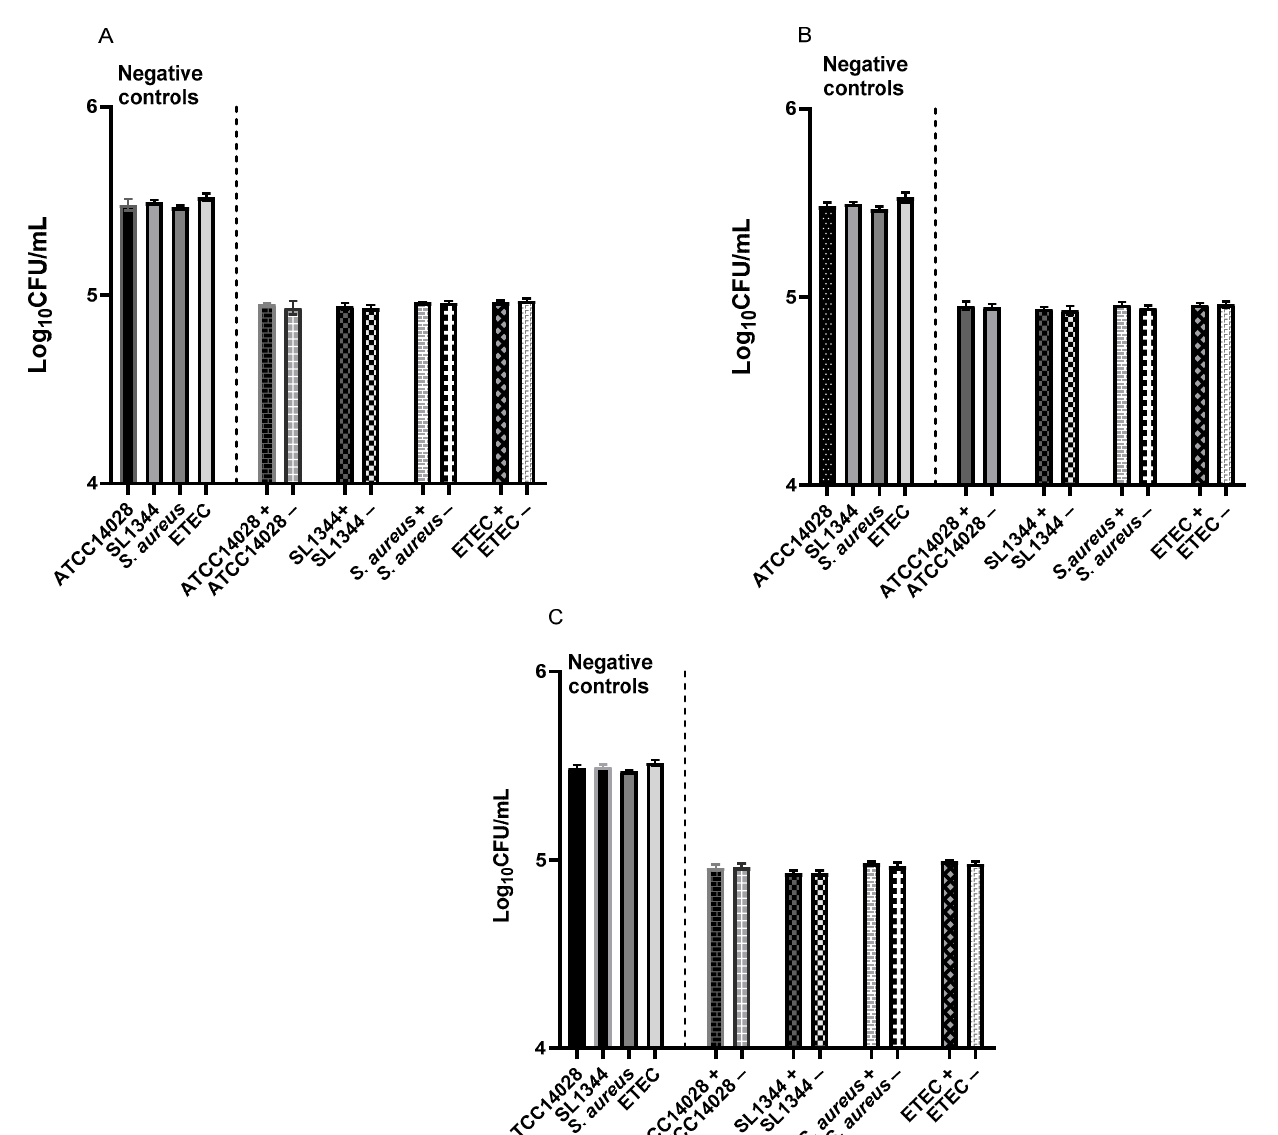
Figure 12. Antimicrobial activity of Lactobacilli culture supernatant and MODE-K cell culture supernatant collected after stimulation with L. acidophilus AR1 ( A ), L. acidophilus AR2 ( B ), and L. fermentum AR3 ( C ). Positive sign (+) represents Lac- tobacillus culture supernatant and negative sign ( − ) represents Lactobacillus -treated MODE-K cell culture